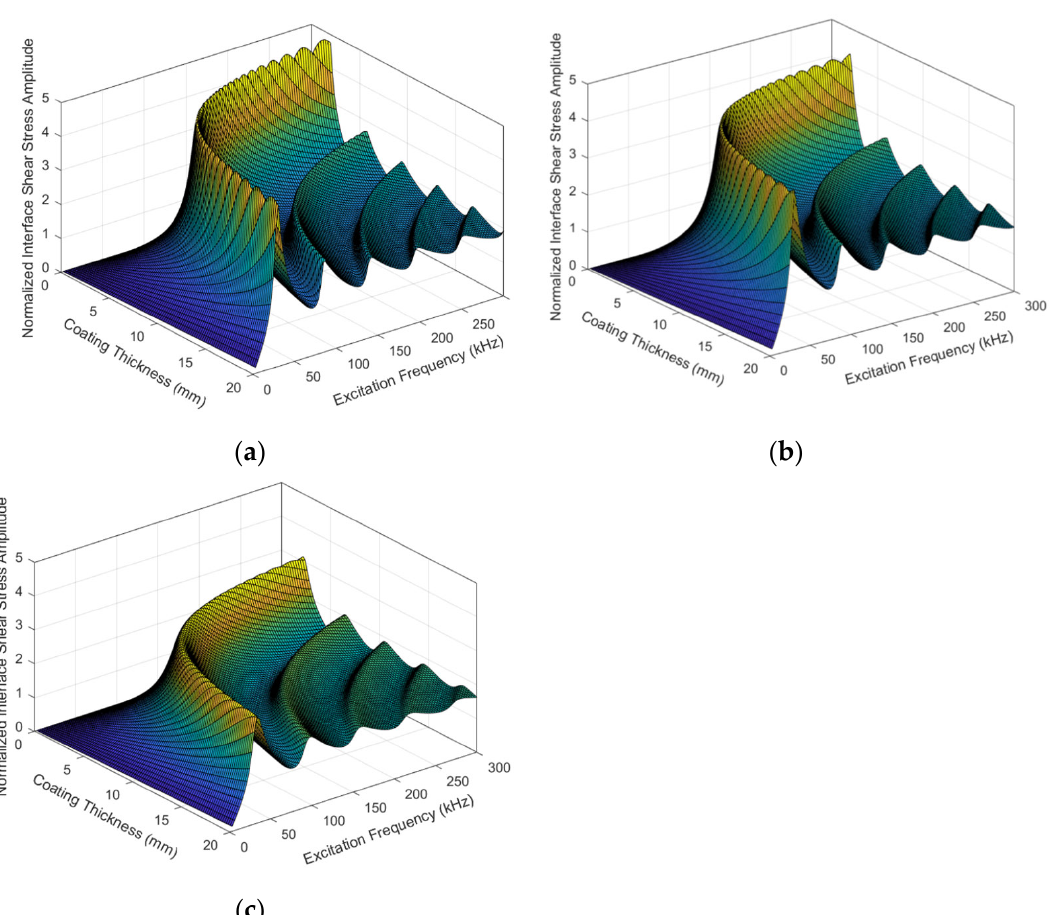
Figure 7. The normalized amplitude of interfacial shear stress in the excitation frequency domain and the coating thickness domain as the coating is frost and the substrate is molybdenum ( a ), steel ( b ) and titanium ( c ).